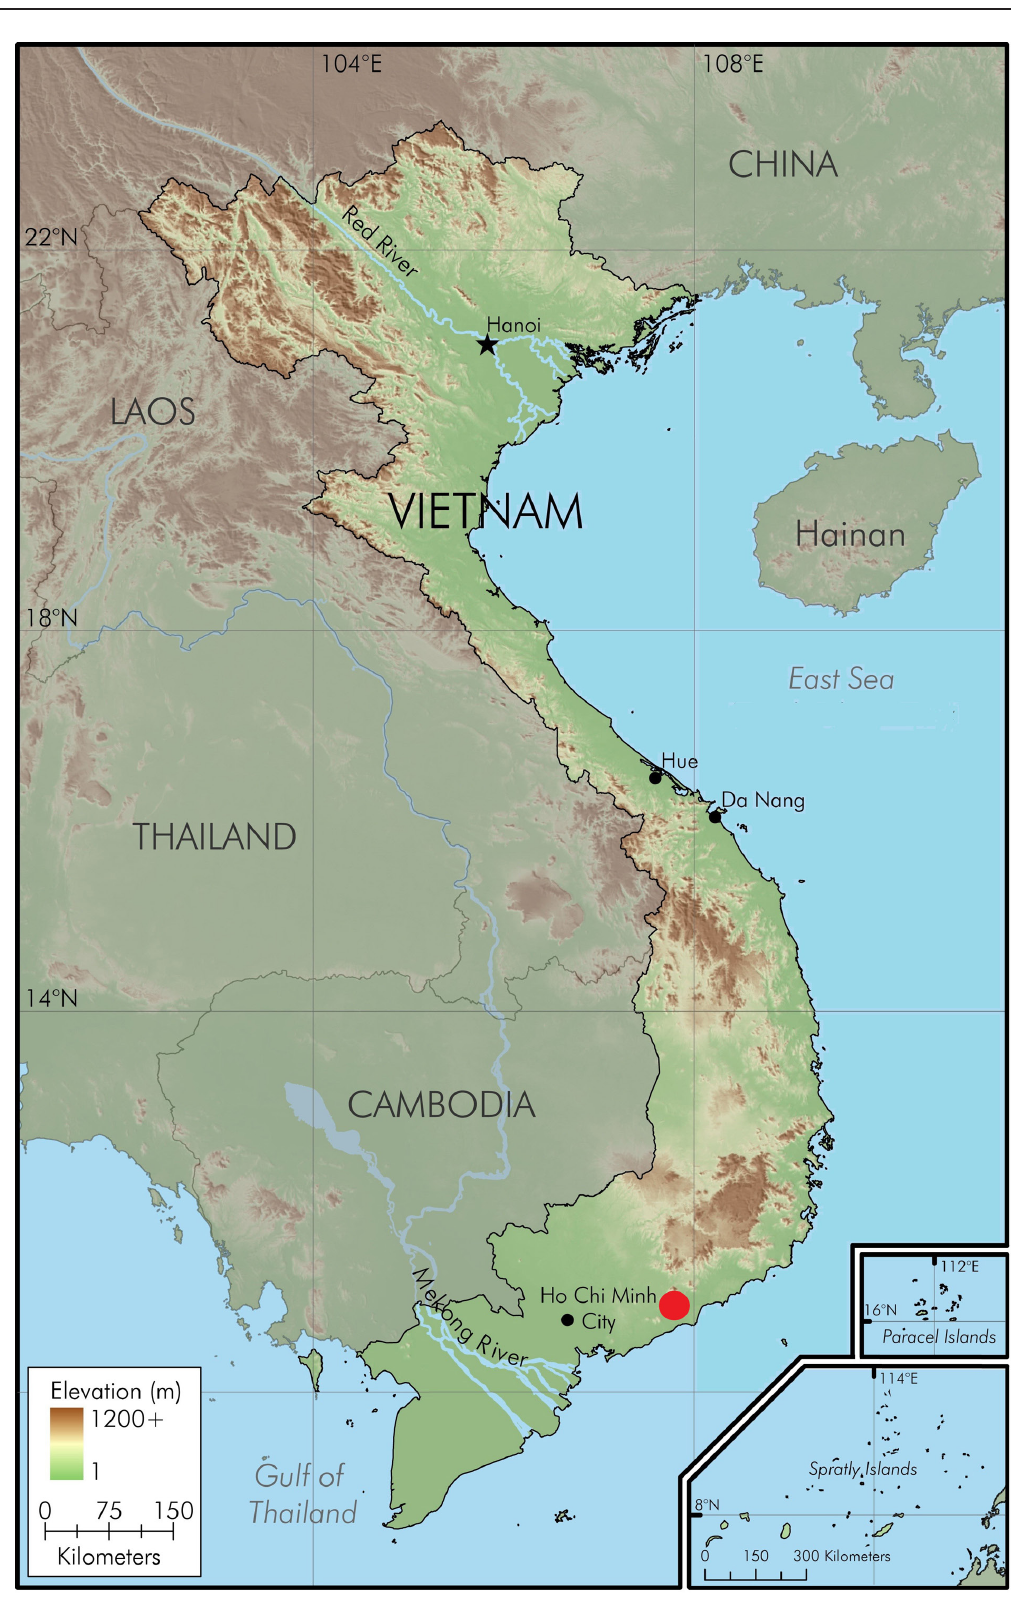
Fig. 1. Map of Vietnam showing the type locality of Cyrtodactylus chungi sp. nov. in Binh Thuan